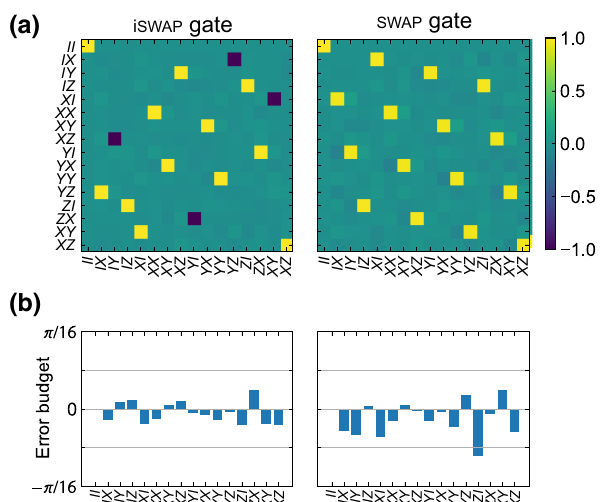
FIG. 4. (a) Pauli transfer matrices of i SWAP (left) and SWAP (right) gates generated with CCR gates, evaluated by QPT exper- iments with measurement-error mitigation. (b) Generator inten- sities of rotation errors in i SWAP (left) and SWAP (right) gates generated with CCR gates, extracted via a channel purification